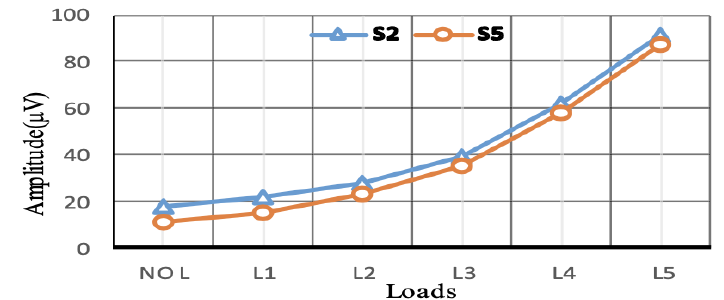
Figure 24. No fault detected [96].